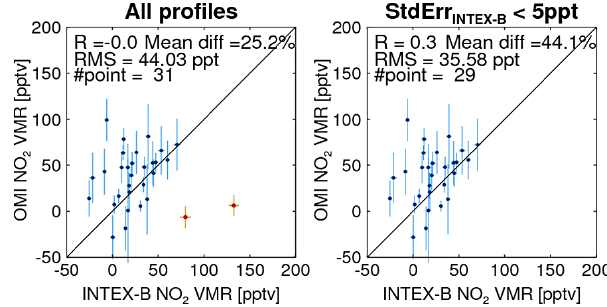
Figure D1. Similar to Fig. 6 but using geometric